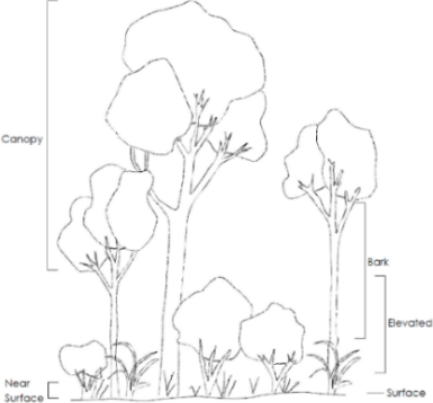
Figure 2: The key structural layers of the fine fuel complex (Hines et al.